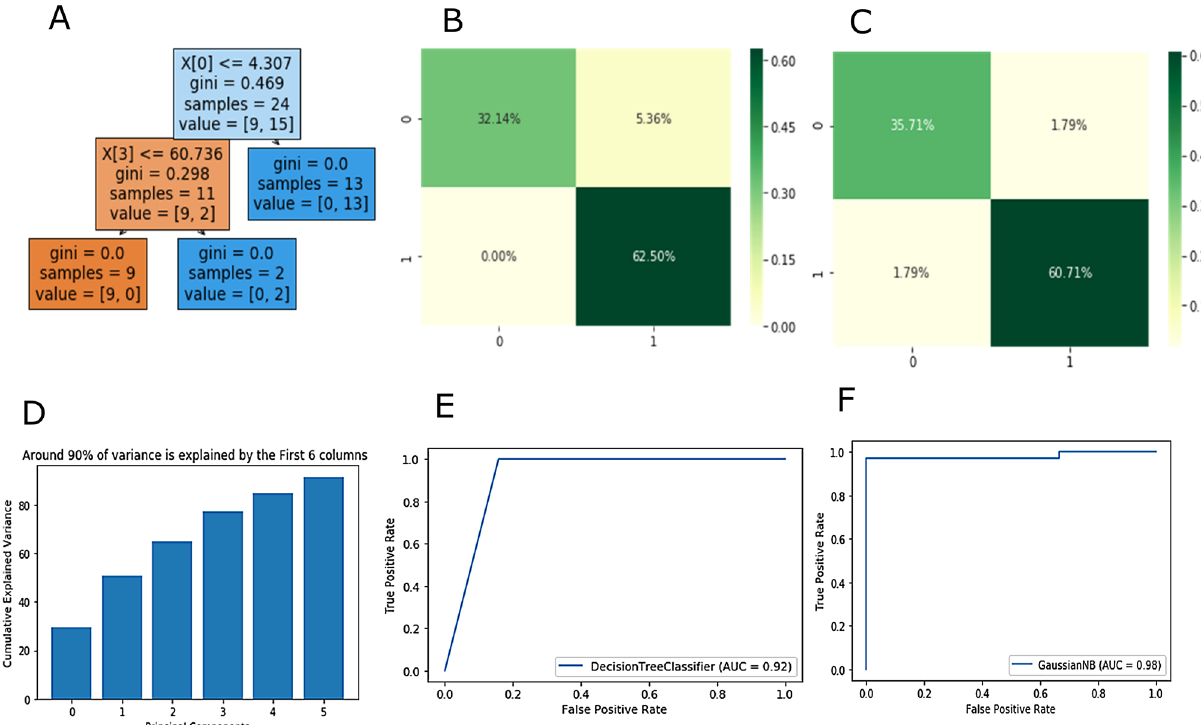
Figure 5. ( A ) Decision tree evolution using CART algorithm, ( B ) Confusion matrix for Decision Tree (CART), ( C ) Confusion matrix for Naïve Bayes, ( D ) Principal component analysis showing 90% variance by first 6 parameters that are biomarkers, ( E ) AUCROC curve for Decision Tree, ( F ) AUCROC curve for Naïve variance was highly dependent on the study protein levels and the qSOFA value. The final model takes account of demographic input parameters age and gender. The summary of demographic information has been added in the supplementary Table S3. As the dataset available is limited, we used k-fold validation to gauge the model’s true performance over dif- ferent training sets. All the k times the training dataset was different from each other and tested on previously unexposed validation set to the model. Having a different set of training and testing set reduces the bias of the model. This way every observation in the dataset can be treated as a part of the training and testing set, compen- sating for the limited datapoint and reducing the variability of the model. The accuracy obtained for the iteration has been logged and average accuracy as considered for the final algorithm selection. The k-fold method was used to get more confidence at the algorithm selection stage. The results obtained from the average value of all iteration is used for finalizing the algorithm for the study. The accuracy of the algorithm was the main criteria for selection. The selected algorithm is further fine-tuned to attain better accuracy and lower the type I and II errors. The classifier decision tree (CART) and naïve Bayes were the top performers in k-fold validation method. Hence, they were further implemented to validate the performance on the test data set. In CART algorithm, at